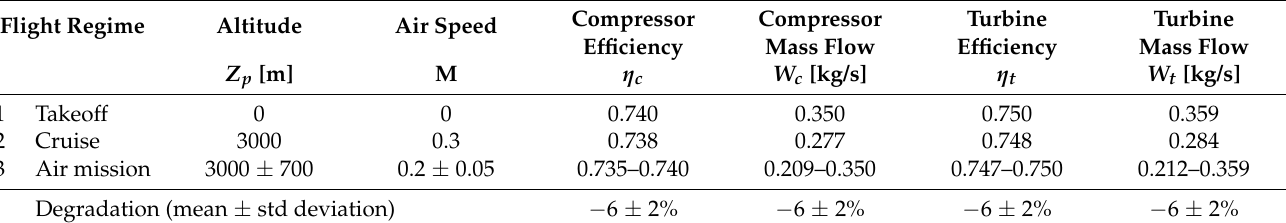
Table 3. Ambient conditions and non-degraded component performance in simulated flight regimes.